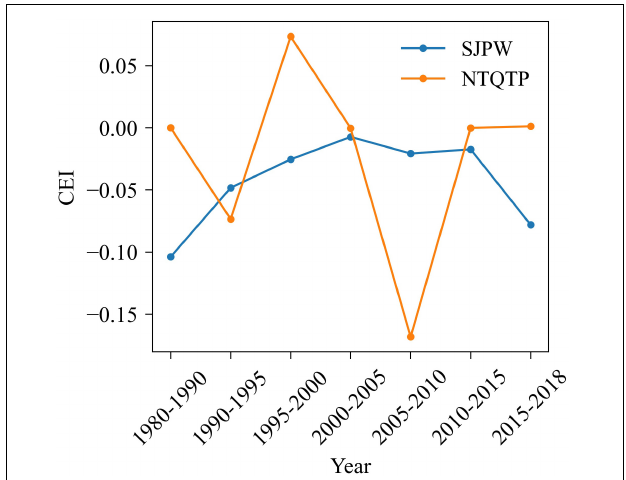
FIGURE 7 | CEI of SJPW and NTQTP from